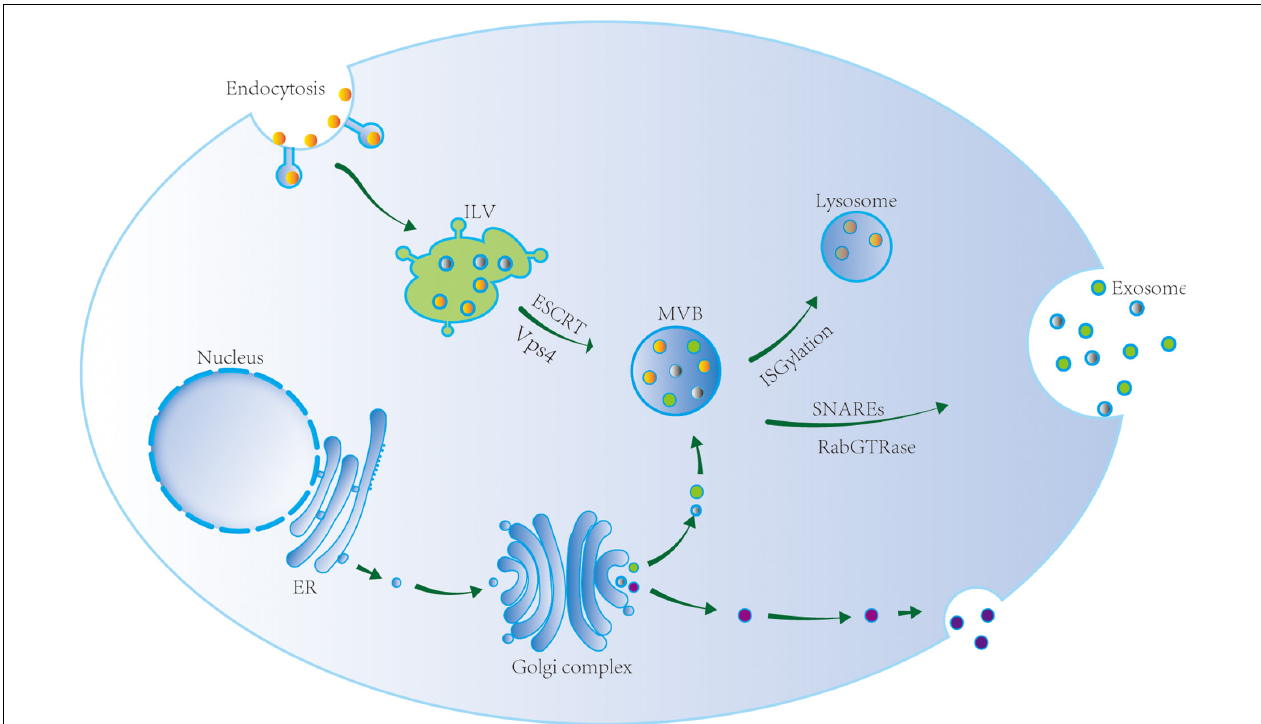
FIGURE 1 | Exosome biogenesis, sorting, and trafficking. Exosomes originate from the endosome system. The endosome membrane invaginates and sprouts to form intraluminal vesicle (ILV), the early endosome. ILV matures to form multivesicular body (MVB) via ESCRT and Vsp4, i.e., the late endosome. MVB reach lysosome after ISGylation and its contents are degraded, or is transported to the cell membrane to release exosomes via SNAREs and